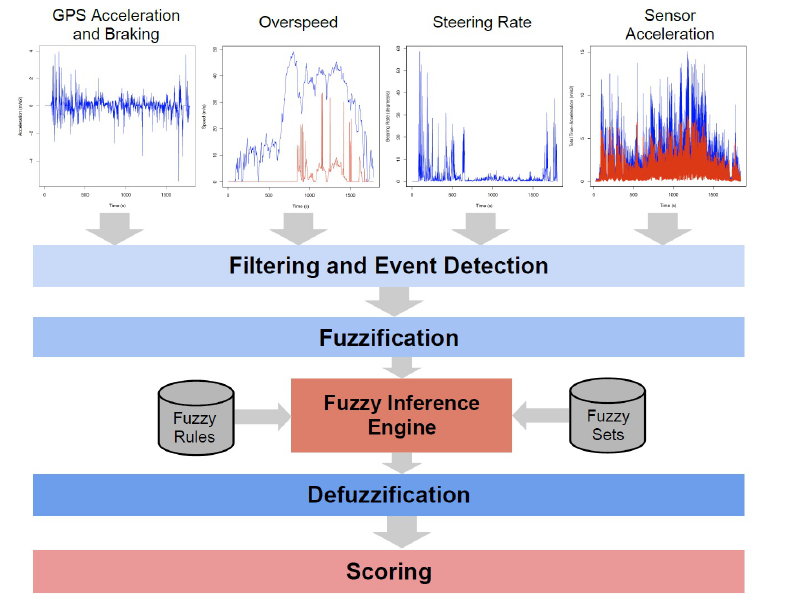
Figure 8. Fuzzy Inference System [56].